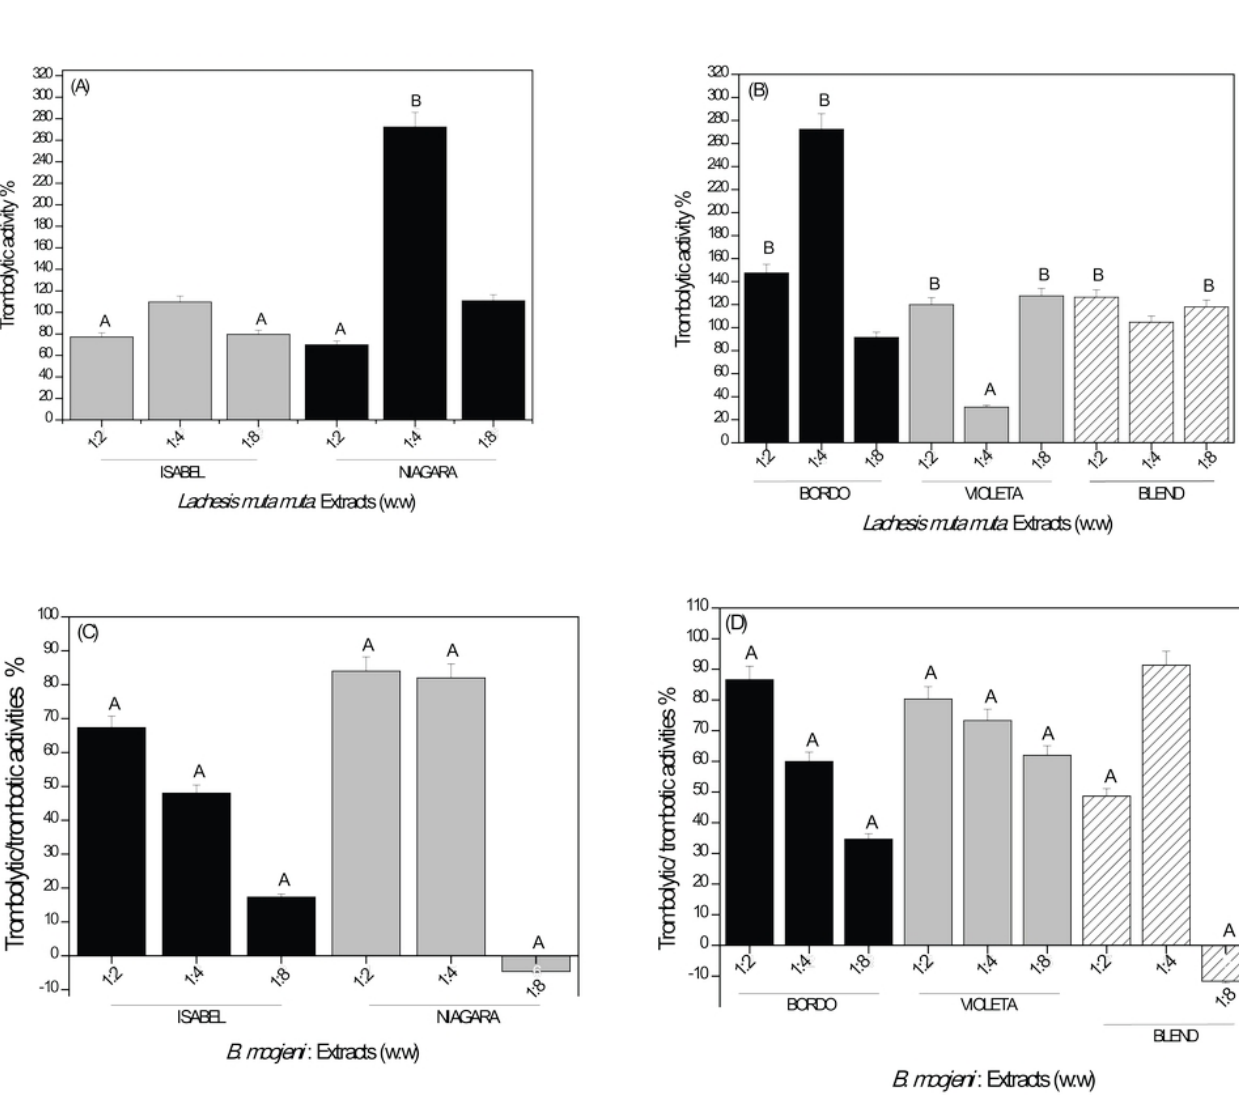
FIGURE 2 - Effect of dried grape pomace from different cultivars on venom-induced thrombolytic activity of Lachesis muta muta (A and B) and Bothrops moojeni venoms (C and D). The data represent means and standard deviation of values obtained in three independent tests performed with samples evaluated in triplicate. Controls (+) containing only venom (30 μg) were considered as 100% activity. A = differs from the positive control in inhibition. B = differs from the positive control in